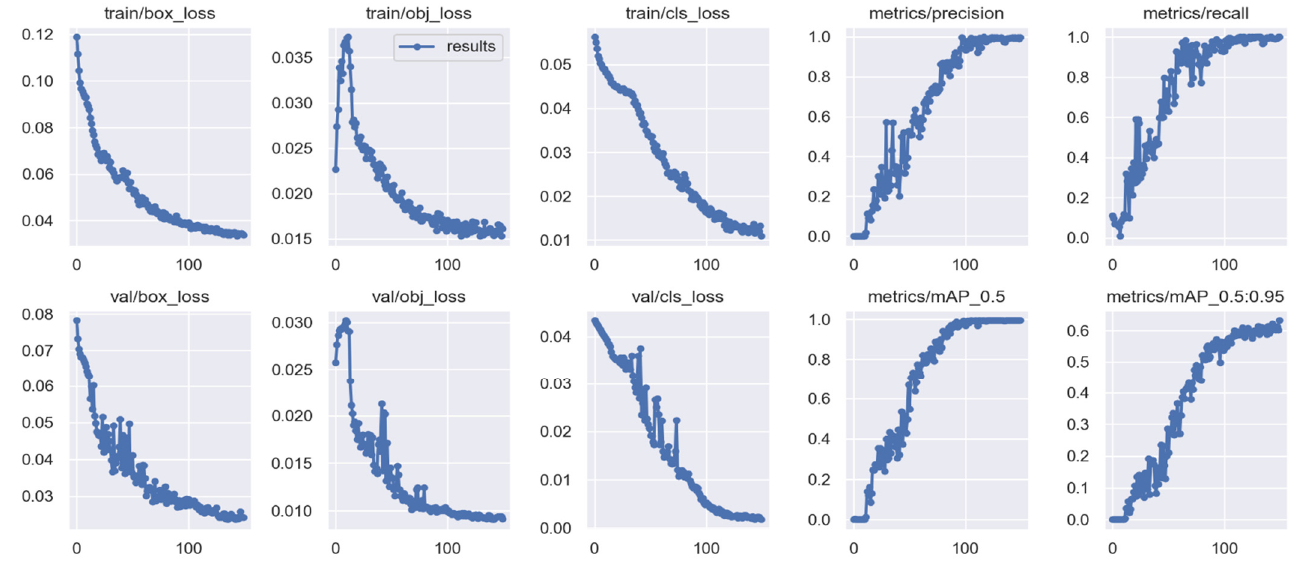
Figure 8. Shows both training and validations of the HCNN algorithm’s object detector and classi- fication loss converging on 100 epochs for passageway scenes dataset. The precision and recall met- rics in the training and validation phase converge at the highest of 95.7% accuracy, whereas the mAP converges at 95% with a 0.5 threshold .